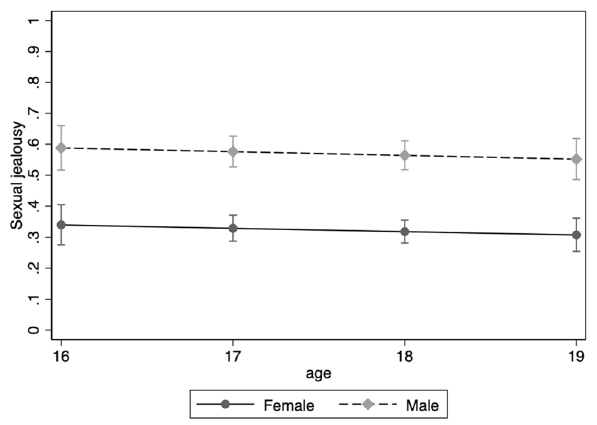
Figure 4. Proportion of female and male students reporting being more upset by the sexual aspect of infidelity at ages 16 through 19 on Scenario